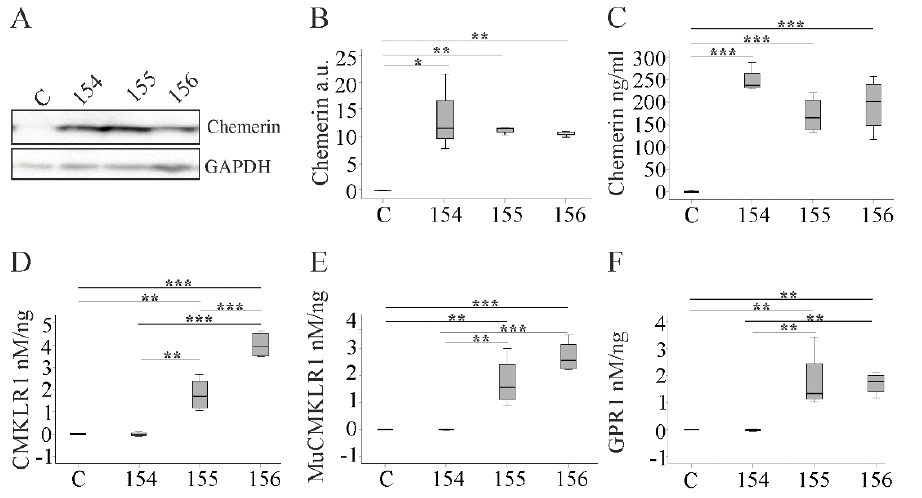
Figure 1. Expression of chemerin isoforms in Hepa1-6 cells. ( A ) Immunoblot of chemerin in lysates of Hepa1-6 cells expressing muChem-154, -155 or -156. C indicates Hepa1-6 cells transfected with the insertless plasmid. ( B ) Densitometry analysis of cellular chemerin measured by Western blot (arbitrary units, a. u.). ( C ) Quantification of chemerin in the media of Hepa1-6 cells by ELISA. Bioactivity of the secreted murine chemerin isoforms, corrected for total media chemerin levels, as measured by the ( D ) human CMKLR1, ( E ) murine (Mu) CMKLR1 and ( F ) human GPR1 Tango assay. Data were analyzed with one-way ANOVA with post-hoc Tukey test * p < 0.05, ** p < 0.01, *** p < 0.001. n = 4.